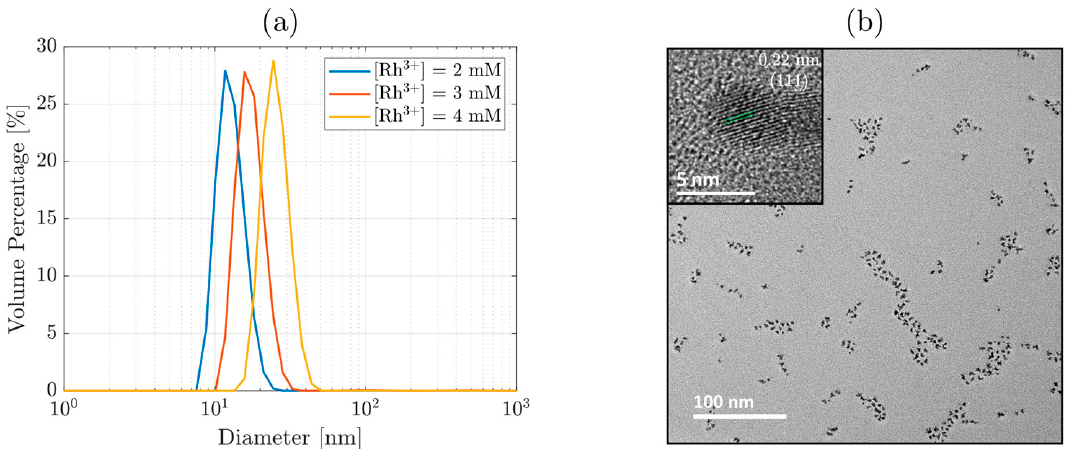
Figure 2. Hydrodynamic size distribution of Rh NPs ( a ), using different Rh precursor concentrations in the synthesis process. ( b ) TEM micrograph of Rh NPs, [Rh 3+ ] = 2 mM, containing an insert with HRTEM on a single particle.